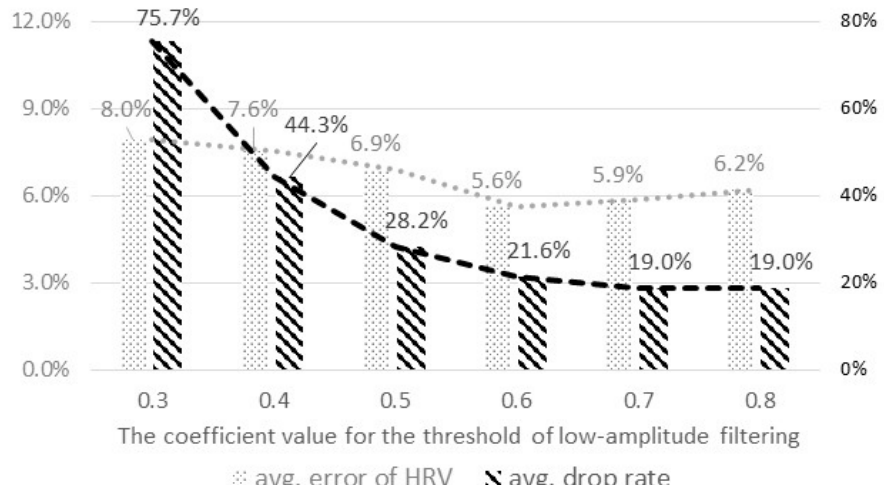
Figure 6. The average error of the HRV parameters and the average drop rate by the coefficient values for the threshold of low-amplitude filtering.